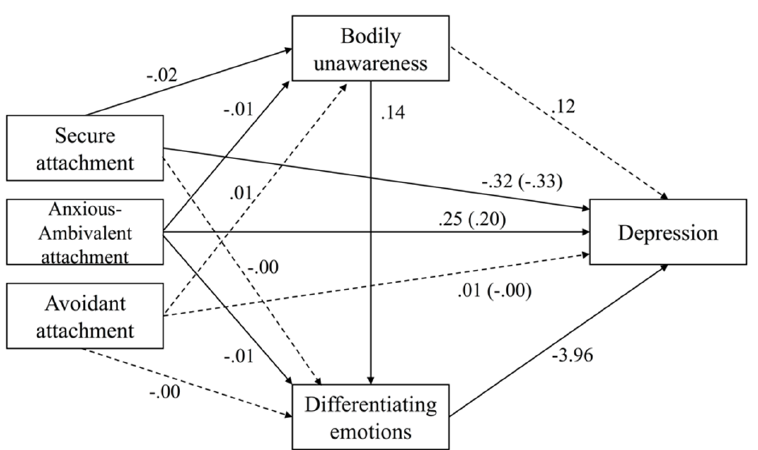
Figure 2. Serial multiple mediation models of the effects of bodily unawareness and differentiating emotions on the relationship between different patterns of attachment and depression. Unstandardized coefficients (direct effects in parentheses). Solid lines indicate significant effects (95% confidence interval does not include zero) and dashed lines illustrate non-significant effects.